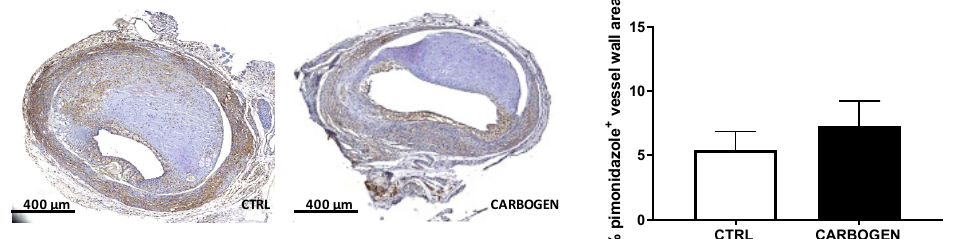
Figure 3. Chronic carbogen treatment does not affect intraplaque hypoxia. Representative pictures of vein graft cross sections stained for pimonidazole in control ( n = 8) and chronic-treated carbogen groups ( n = 13) and quantitative measurement of percentage of vessel wall area positive for pimonidazole staining. Data are presented as mean ± SEM.